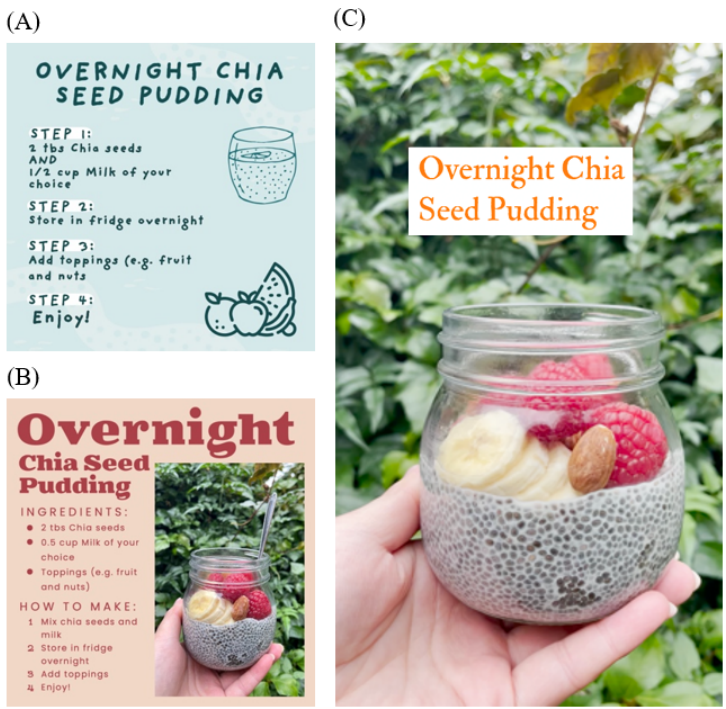
Figure 1. Sample set of three mock Instagram social media posts for a chia seed pudding recipe in the following formats: ( A ) text and icons only; ( B ) realistic image; and ( C ) short